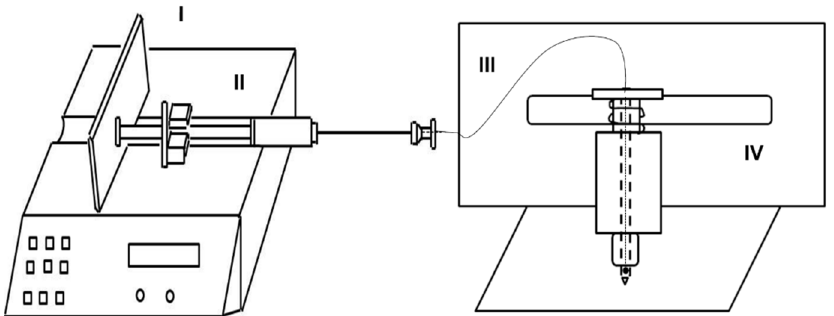
Figure 1. Schematic sketch of SpitWorm. (I) Syringe pump controlling the fluid flow rate; (II) syringe (100 μ L) filled with diluted oral secretions (OS); (III) capillary from the syringe to the tip of MecWorm’s hollow punching needle; (IV) MecWorm, a robotic system for continuous wounding. For headspace volatiles, collection of control and S. littoralis treated leaves, and for MecWorm